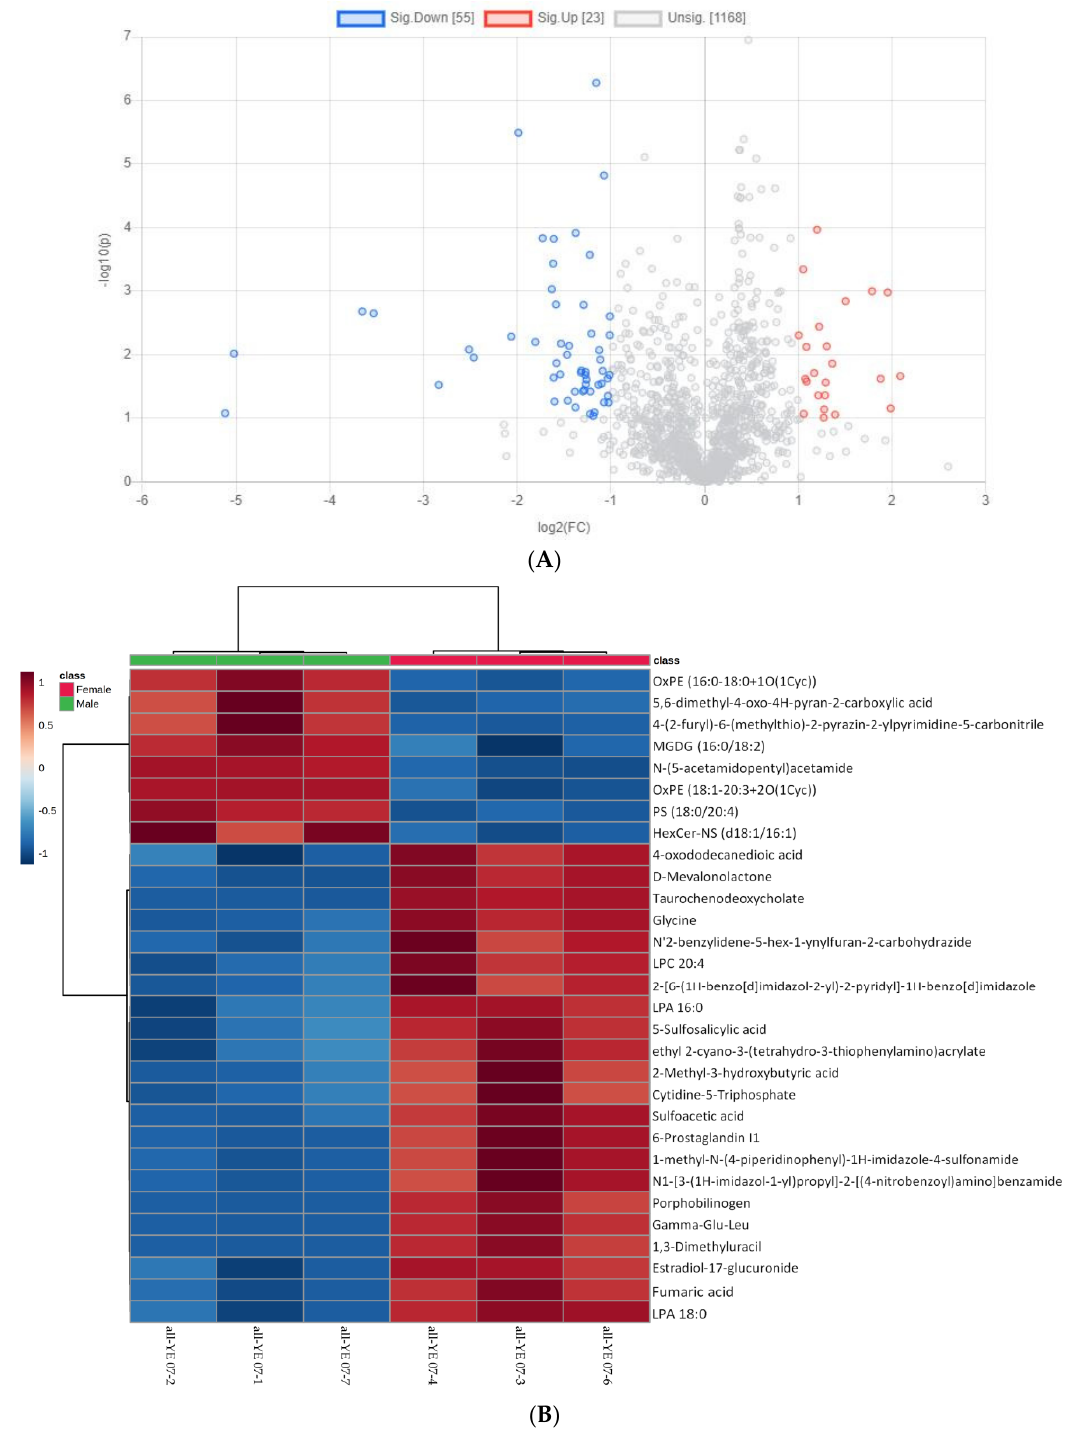
Figure 2. Differential yolk metabolites identified from male and female chicken embryos at E7 ( n = 3). ( A ) The volcano plot shows the combination of the fold changes and the p values of each metabolite. The red dots represent the metabolites that were significantly upregulated in female birds, while the blue dots represent the metabolites that were significantly downregulated in female birds. ( B ) Heatmap showing the difference profile of yolk metabolites between male and female chicken embryos. Each cell in the plot corresponds to a normalized z-score value. Sample names are in columns and compound names are in rows.